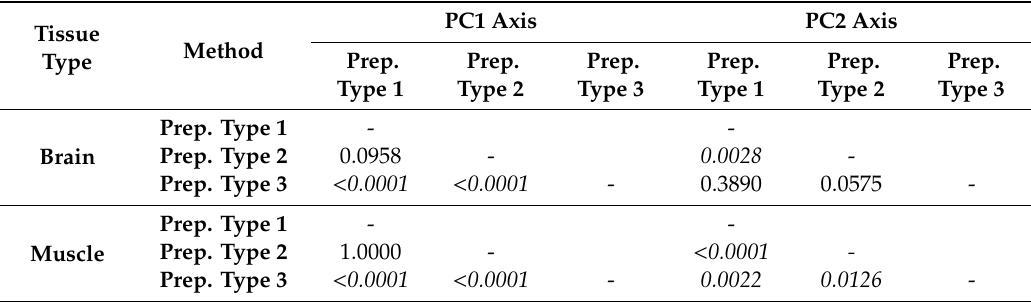
Table 2. Results of Kruskal-Wallis pairwise comparisons of the three sample preparation types’ PCA data. The significant pairwise group di ff erences / p < 0.05 / are italicized.